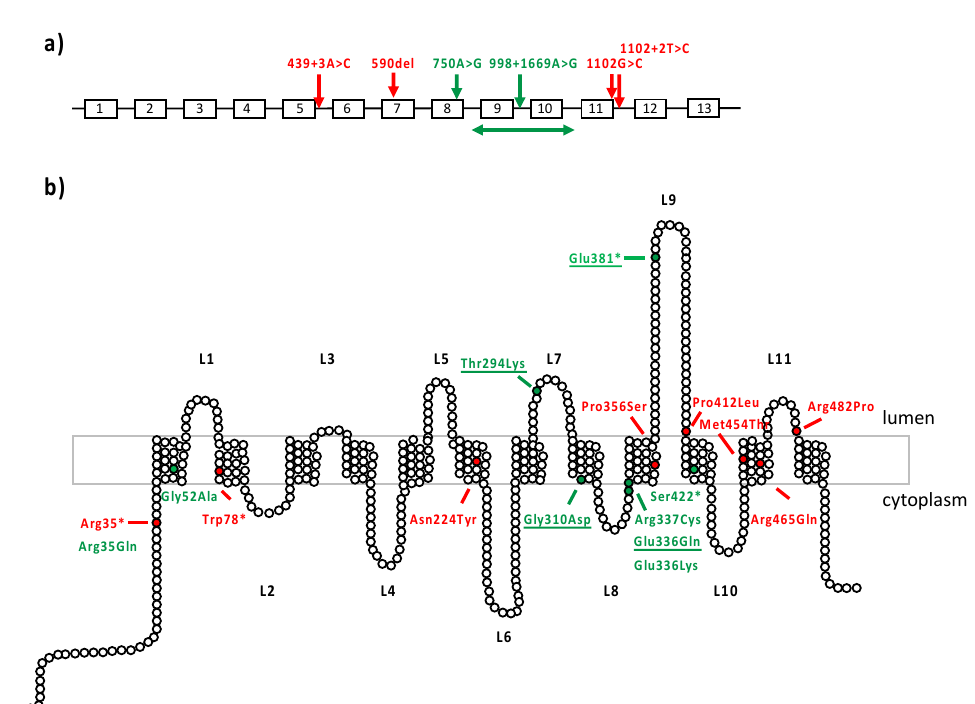
Figure 3. MD-associated MFSD8 variants. ( a ) Loss-of-function variants reported in macular dystro- phy. MFSD8 gene is represented with its 12 exons. Variants are annotated according to the cDNA nomenclature. In red are variants from the literature and in green are novel variants identified in this study. ( b ) Missense variants reported in macular dystrophy. CLN7 is composed of 12 transmembrane domains and 11 extracellular or cytoplasmic loops. The 518 amino acids of CLN7 protein are depicted as white circles. In red are variants from the literature; in green are novel variants identified in this study; underscored are the already reported variants found in our study.